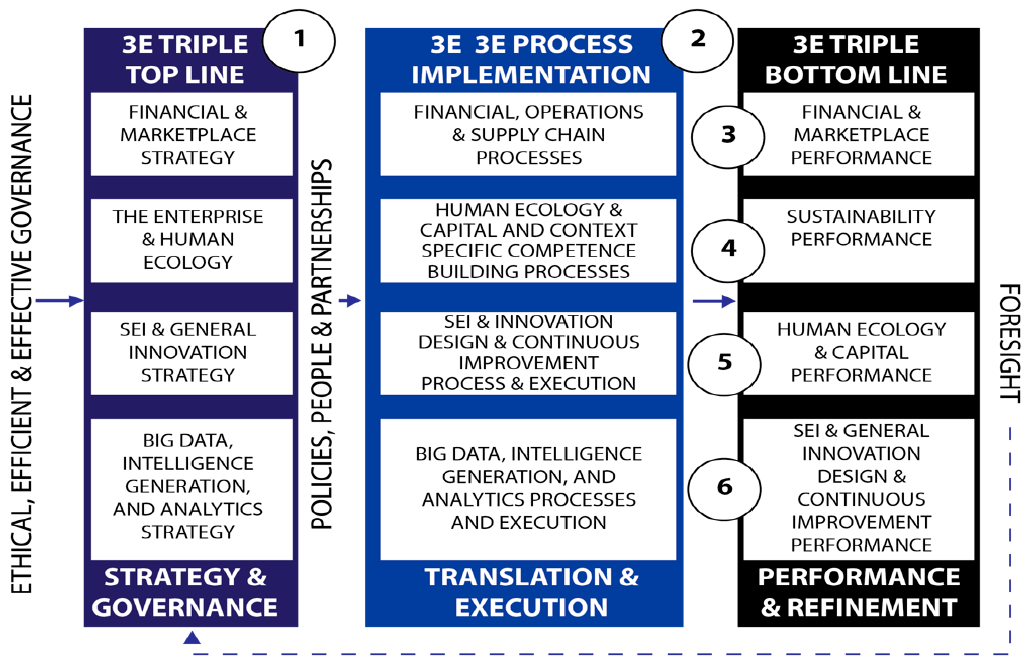
Figure 6. Ecosystem Model for Systemic Change (reproduced with permission from [77] (p. 971)).